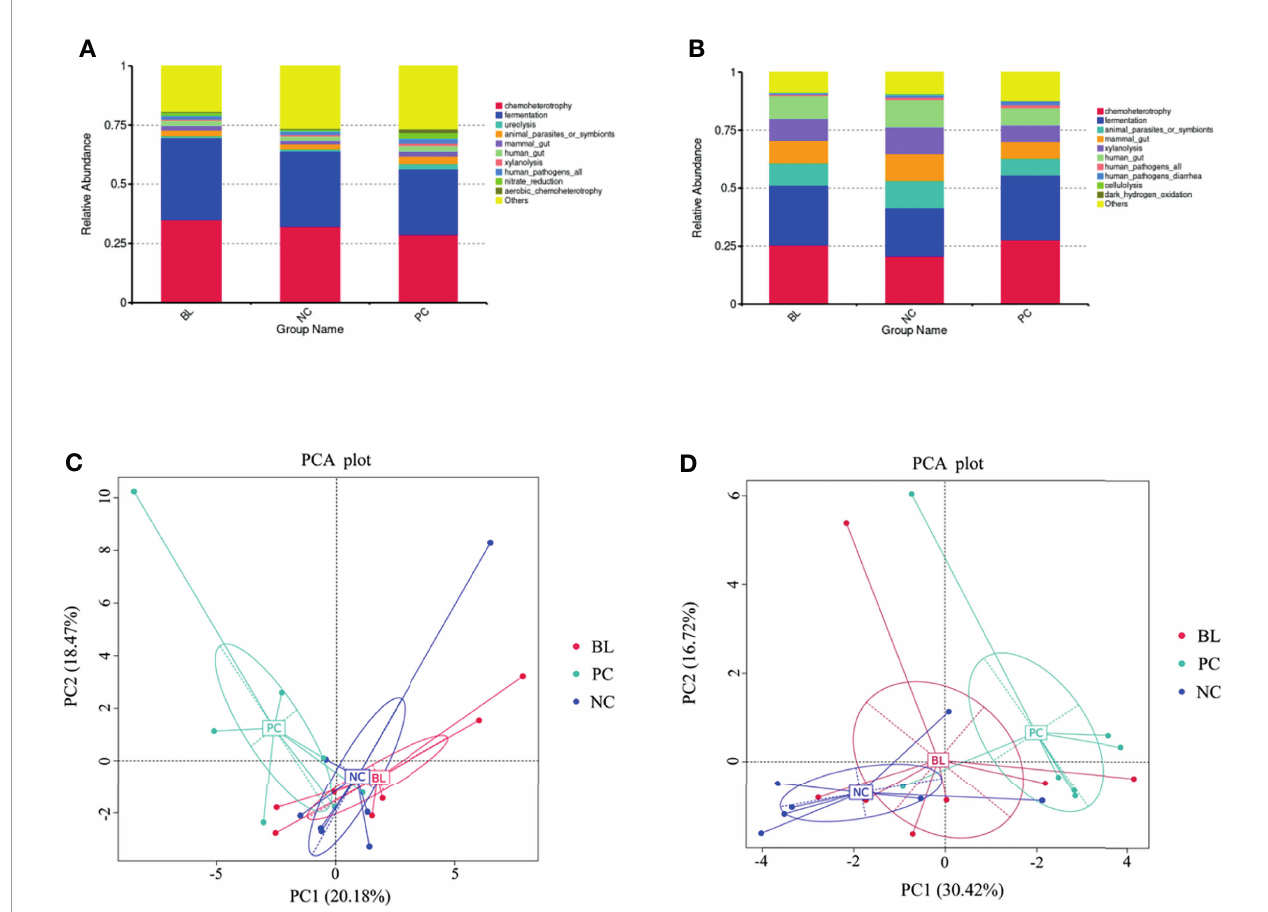
FIGURE 10 | Probiotic H2 normalizes the function of the ileum (A, C) and the cecum bacteria (B, D)